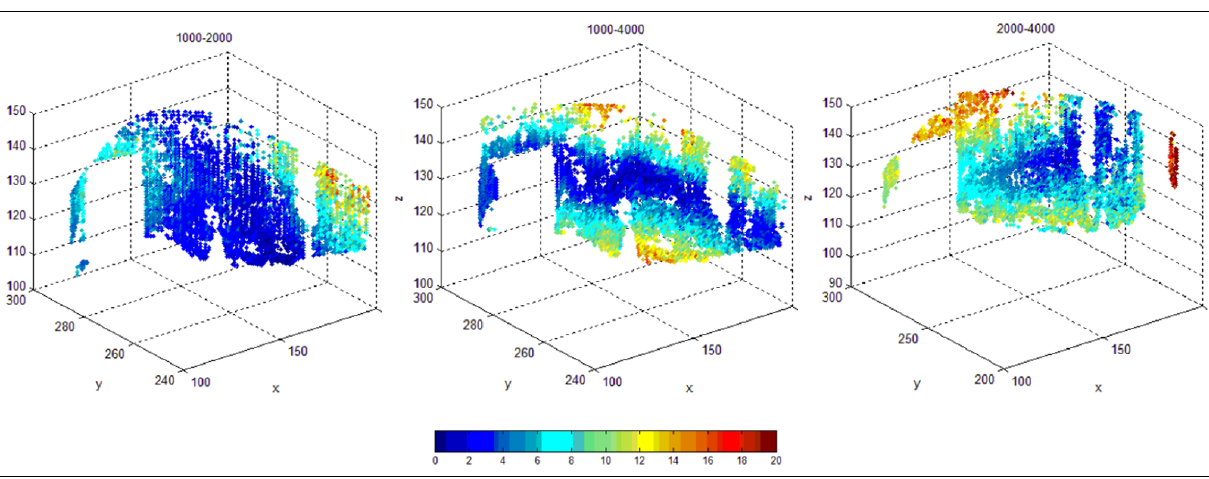
Figure 5. Distance discrepancies of representative points between two scans in epoch 4 (fine registration with six-parameter transformation)(mm) (the left figure means the variations of distance discrepancies between station 1000 and station 2000 ; the middle one is the variations of distance discrepancies between station 1000 and station 4000 ; the right figure denotes the variations of distance discrepancies between station 2000 and station 4000